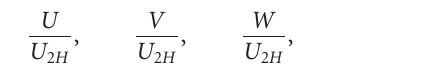
Figure 4: Wind profile measurement locations. Table 1: Parameters of modelled boundary layer above the measured area (in full